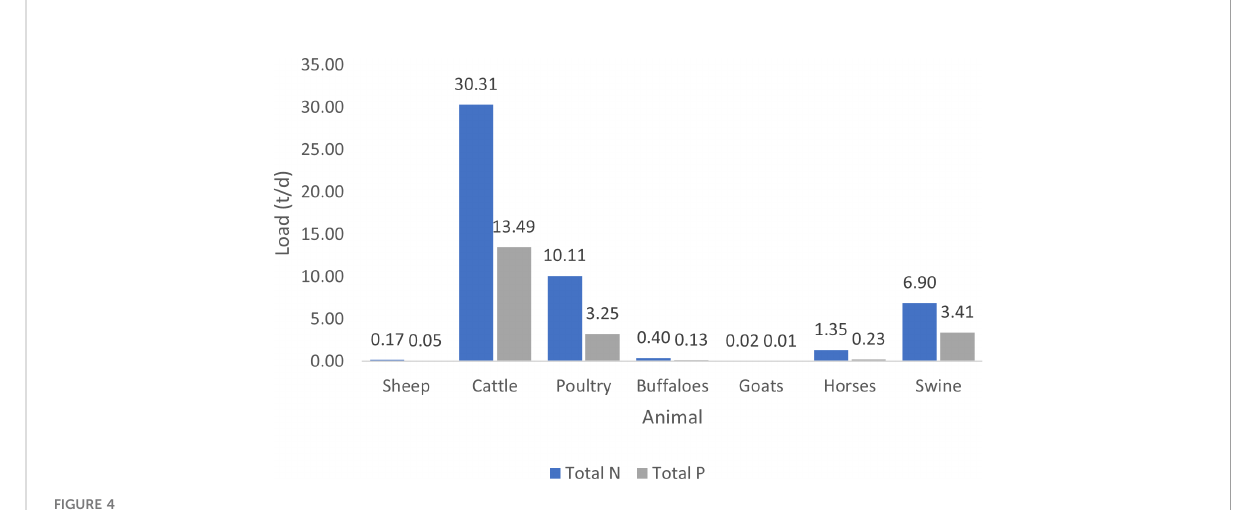
FIGURE 4 Nutrient loads from livestock manure by animal